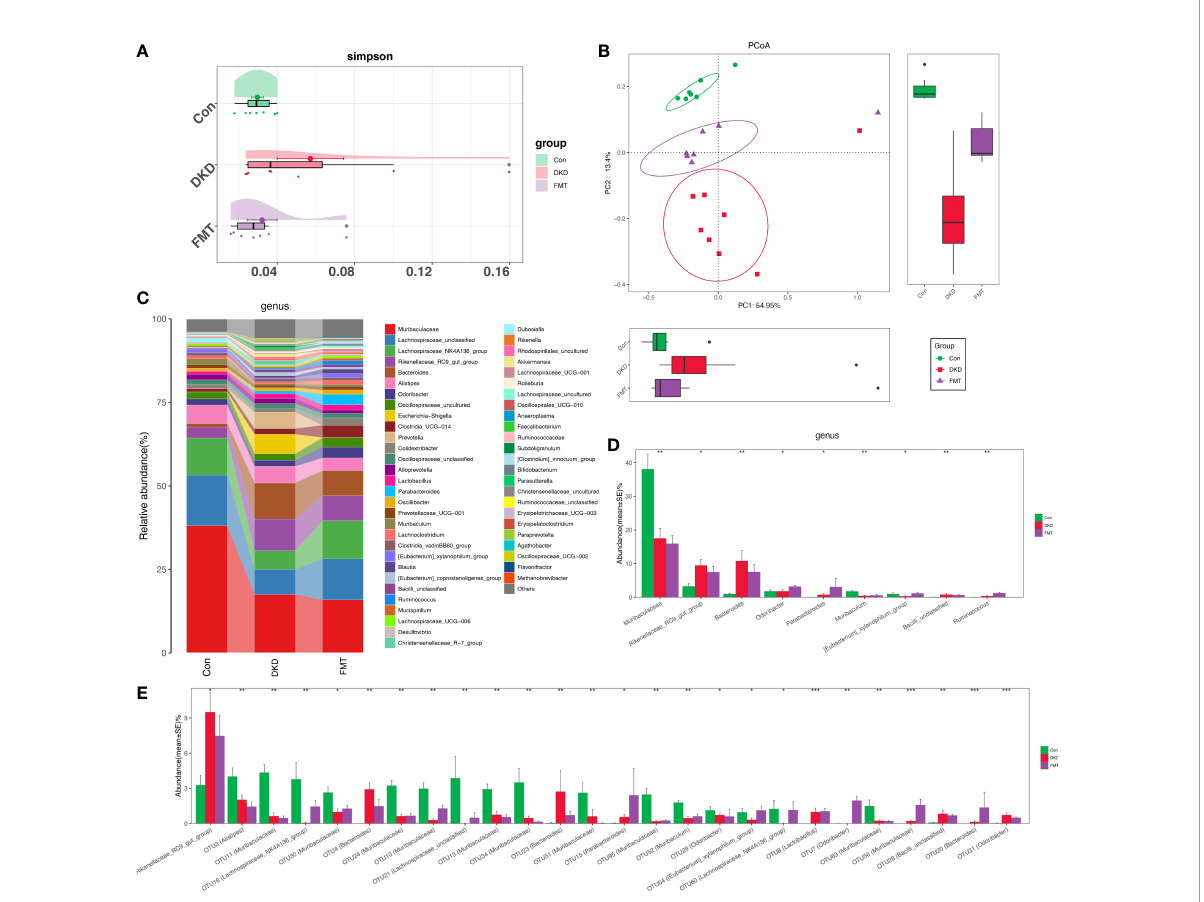
FIGURE 7 Bacterial diversity and compositional alteration analysis of mouse models. Simpson indices (A) and PCoA analysis (B) were used to assess a and b diversity, respectively. PCoA analysis was measured by unweighted UniFrac distance at OTU level. Adonis revealed that unweighted analysis taking OTU abundance into account could better re fl ect the spatial differences among three groups ( R 2 = 0.2233, p = 0.0001). Intestinal microbial composition at the genus level (C) . Kruskal – Wallis rank-sum compares and identi fi es signi fi cantly altered bacteria at the genus and OTU level and the genus (D) or OTU (E) with gradually increased or decreased abundance between three groups was